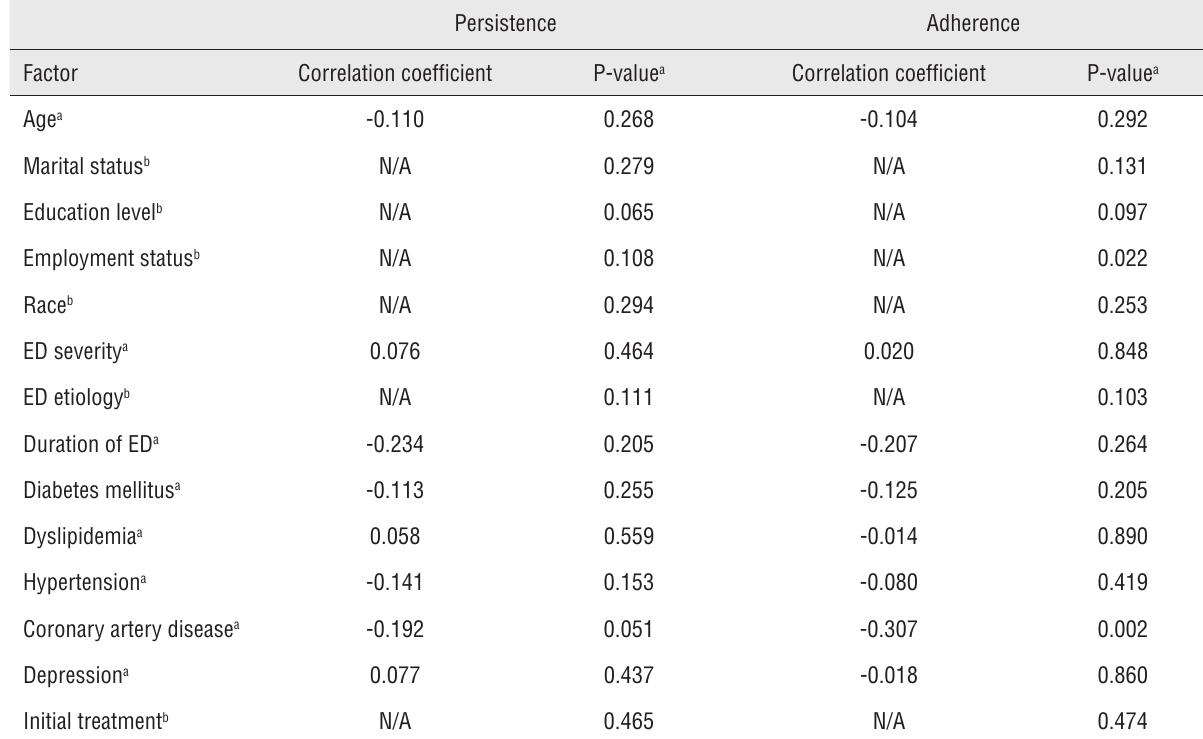
Table 4 - Correlation of Factors with Treatment Persistence and